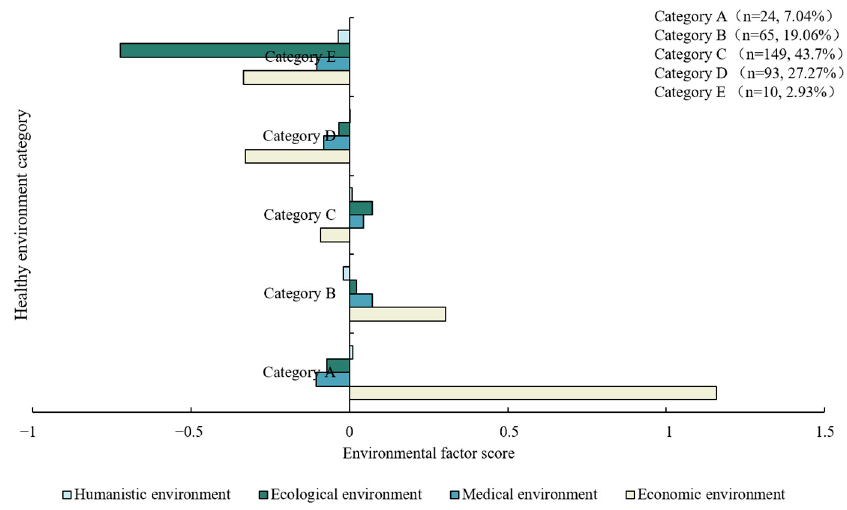
Figure 2. Classification characteristics of five healthy environments.